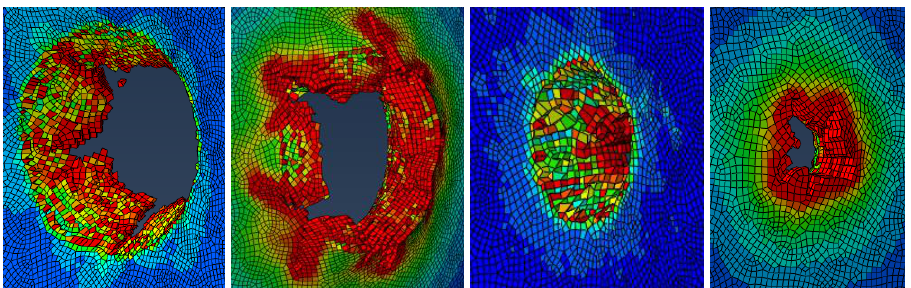
Fig. 5. Simulation of multi-layered protection system at 226 m/s. Johnson-Cook damage initiation field. From left to right: front face of the front plate, rear face of the front plate, front face of the rear plate, rear face of the rear plate.